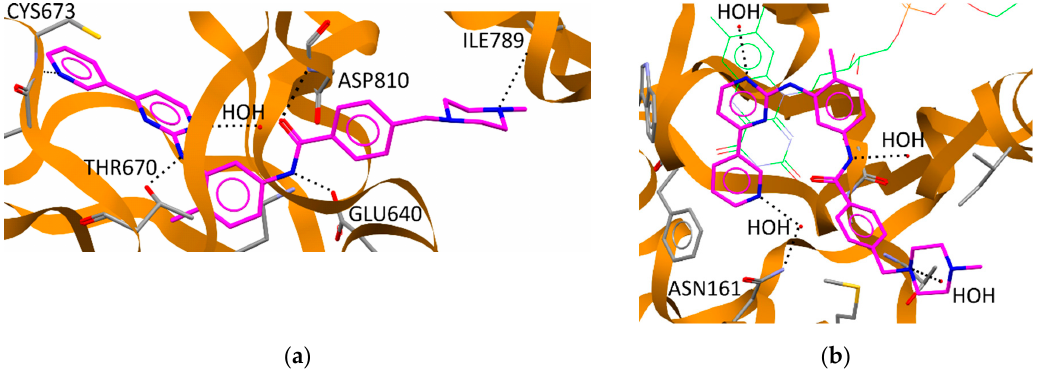
Figure 4. H-bonded motifs in crystals of imatinib complexes with ( a ) tyrosine kinase (PDB code: 1T46 [34]) and ( b ) quinone oxidoreductase (PDB code: 3FW1 [29]). H-bonds are dotted. Hydrogen atoms are